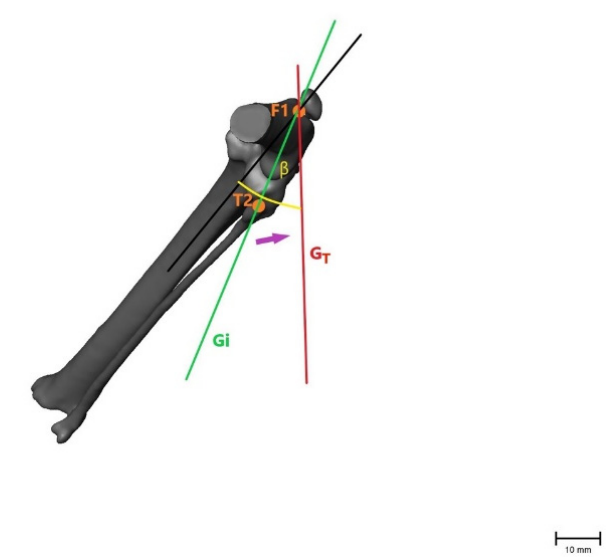
Figure 5. Illustration of the changes within the angle representing internal rotation of the tibia ( β ), showing that the angle becomes larger after CrCL transection as with internal rotation of the tibia when the fibular head (T2) moves laterally. β = measured angle; orange point T2 = fibular head in an intact CrCL; orange point F1 = proximal aspect of the trochlea groove in an intact CrCL; green line G i = vector between measured points with an intact CrCL; red line G T = vector between measured points with a transected CrCL; violet arrow = illustration of movement when the CrCL is transected. Scale bar indicates 10